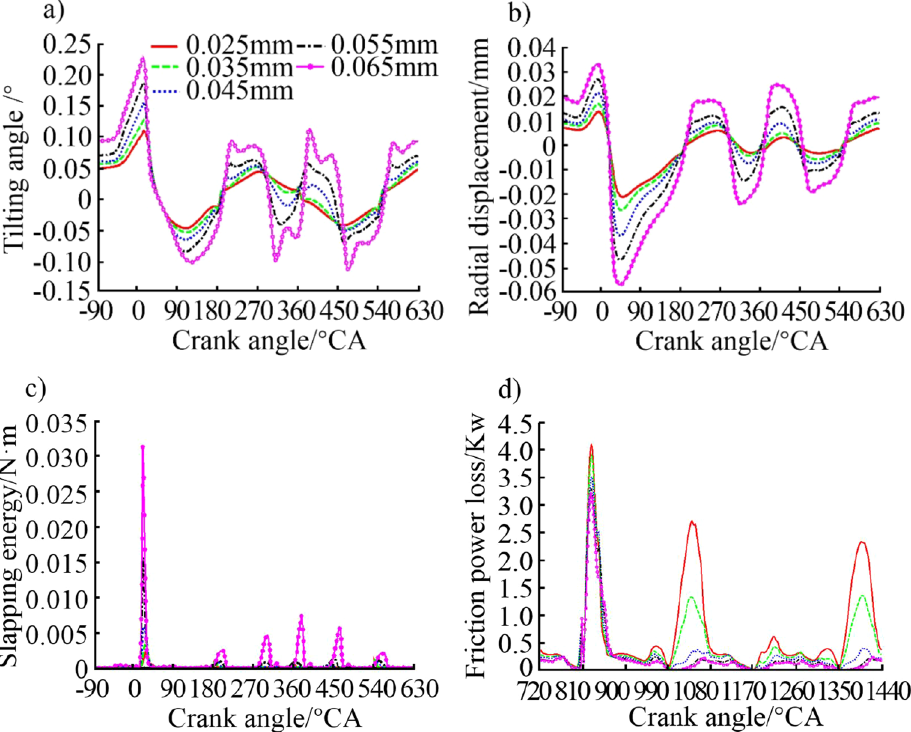
Figure 11. Effect of liner clearance on ( a ) piston tilting angle, ( b ) piston radial displacement, ( c ) piston slapping energy, and ( d ) piston friction power